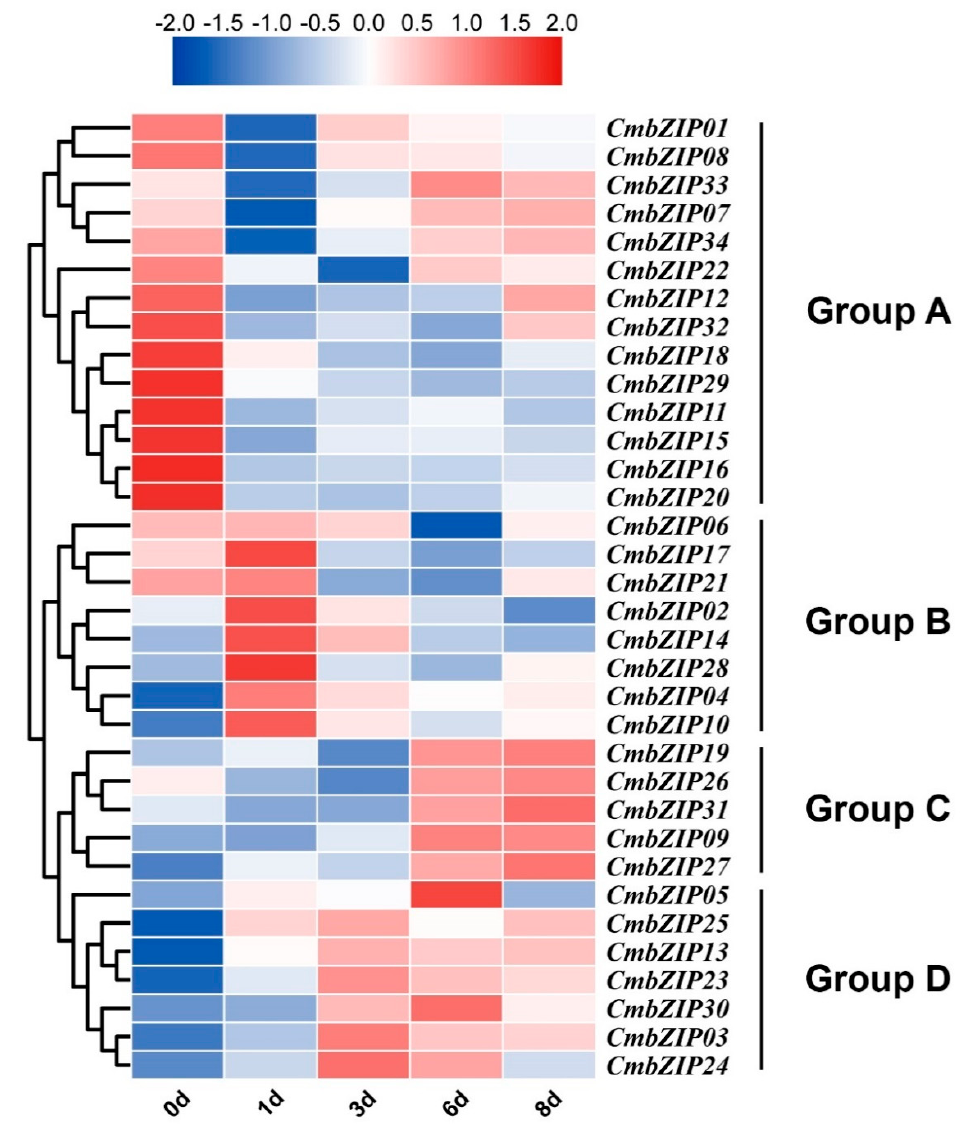
Figure 8. Expression profiles of CmbZIP genes in the process of mycoparasitism. Expression of CmbZIP s in the process of mycoparasitism as determined by RNA-Seq. The original FPKM values of CmbZIP genes were transformed by log2. The color scale represents the fold change in the gene expression value, i.e., red for upregulated and blue for